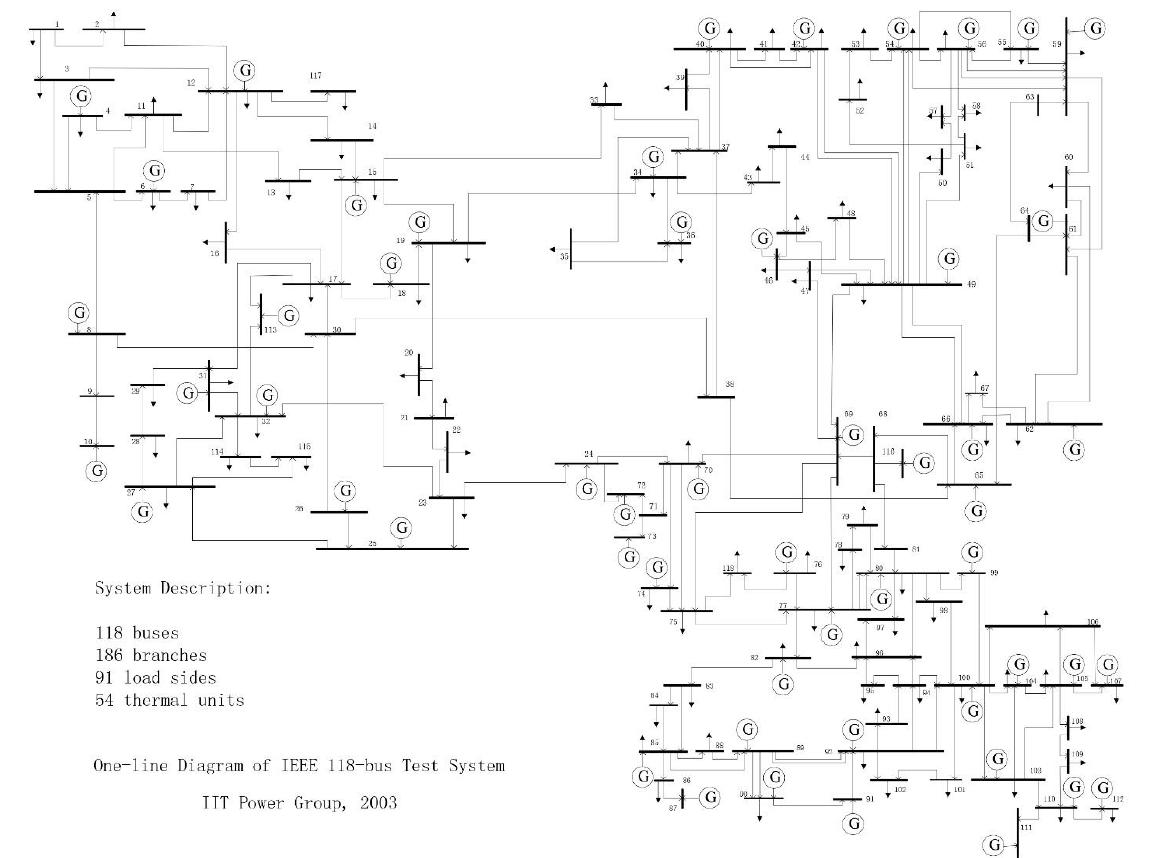
Figure A3. Single-line diagram of the IEEE 118-bus test system. Table A7. Emission coefficients of units for linear model of emission function.